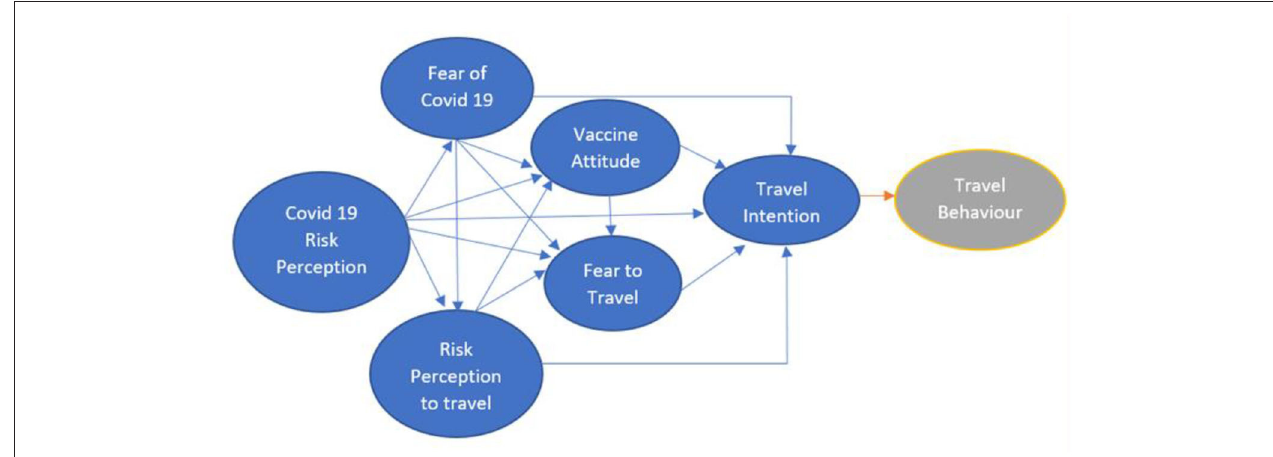
FIGURE 1 | Assumed